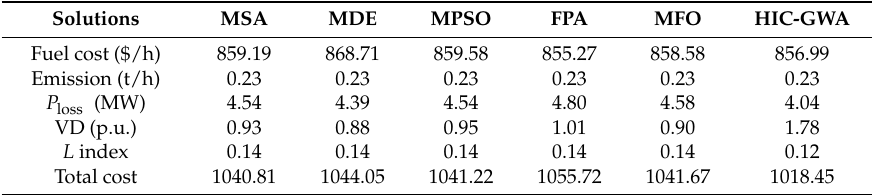
Table 11. HIC-GWA solutions compared with the literature for case